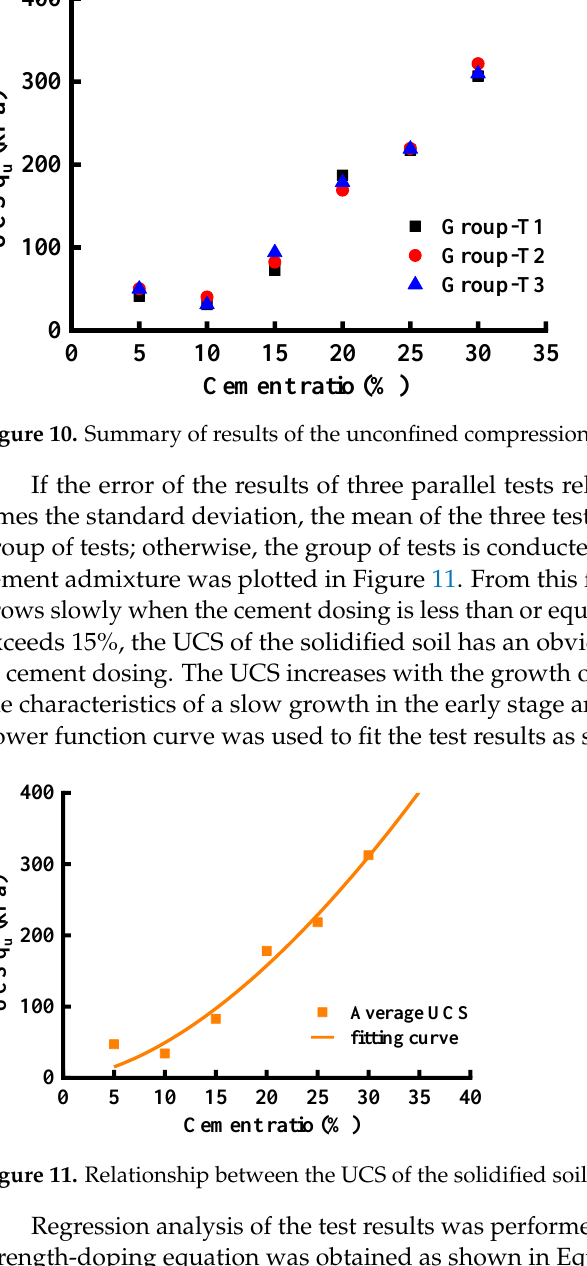
Regression analysis of the test results was performed using a power function, and the strength-doping equation was obtained as shown in Equation